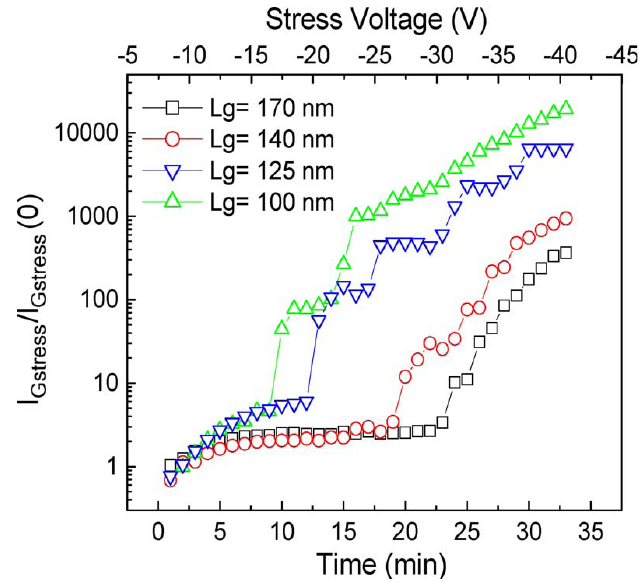
Figure 6. Gate current vs voltage before and after high reverse gate bias step stress for AlGaN/GaN HEMT.